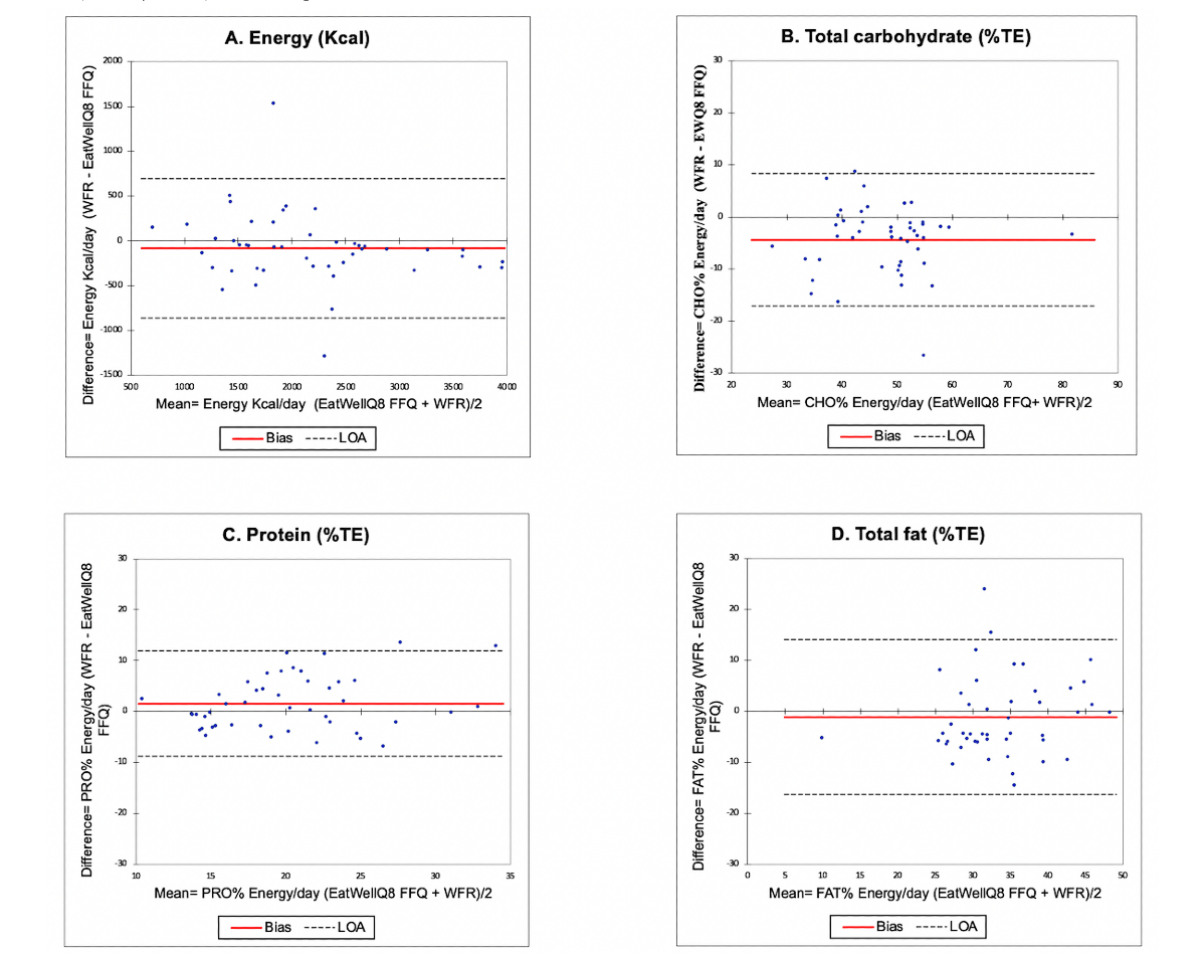
Figure 5. Validation study of Bland-Altman plots comparing the EatWellQ8 food frequency questionnaire with a four-day weighed food record for (a) energy, (b) total carbohydrate, (c) protein, and (d) total fat with the bias (mean difference) and limits of agreement. The solid line represents the bias (mean difference), and the dotted lines represent the limits of agreement. %TE: percentage total energy; CHO: carbohydrates; FFQ: food frequency questionnaire; PRO: protein; WFR: weighed food